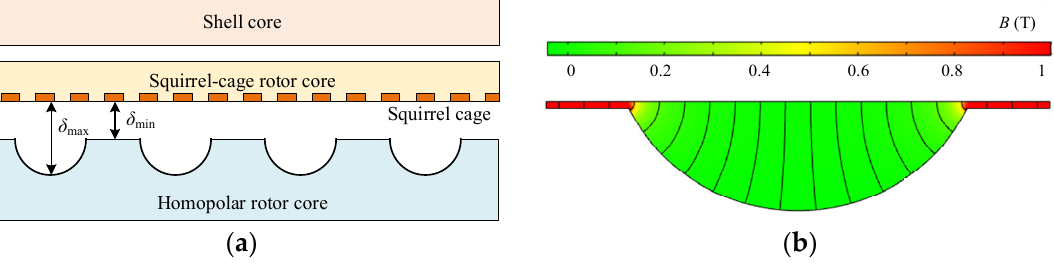
Figure 7. The axial view of the HTR-ASD and no-load magnetic density distribution within one rotor tooth pitch. ( a ) The axial view of the HTR-ASD. ( b ) No-load magnetic density distribution within one rotor tooth pitch.